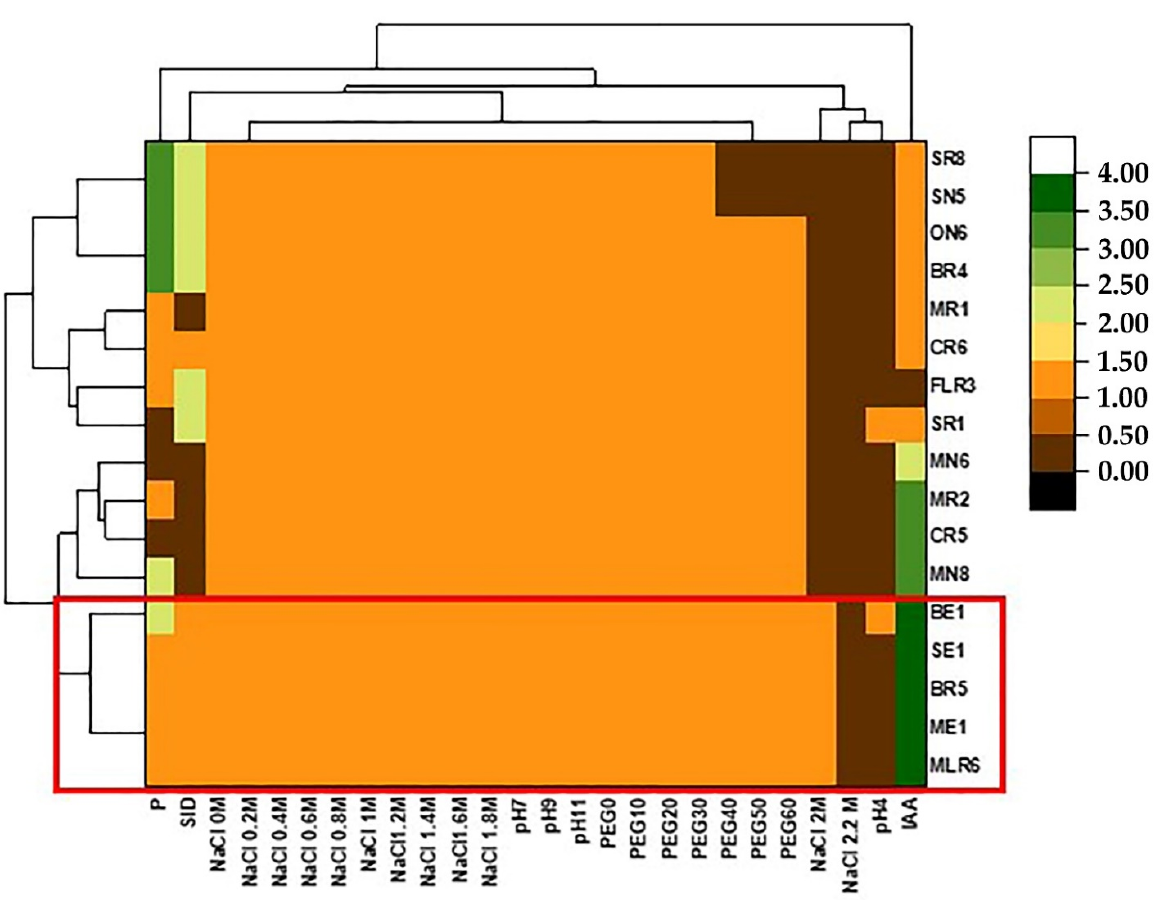
Figure 6. Heat map showing the response of the isolates to different stress tolerance (NaCl, pH, and PEG) and the expression of their PGP activities (IAA, P, and SID). The bacterial isolates (BE1, BR5, ME,1 SE1, and MLR6) having the best capacities are highlighted with the same colors.